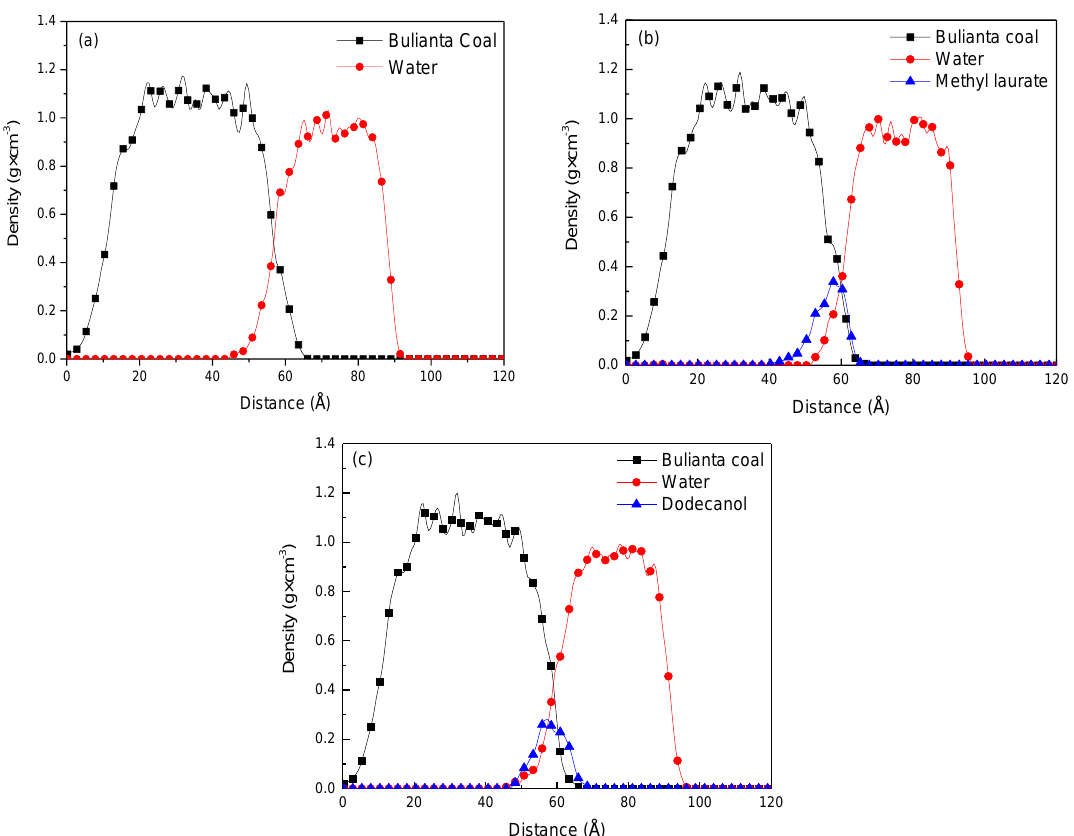
Figure 10. Mass density distributions of coal, collectors, and water: ( a ) Water / coal, ( b ) water / methyl laurate / coal, and ( c ) water / dodecanol / coal system.